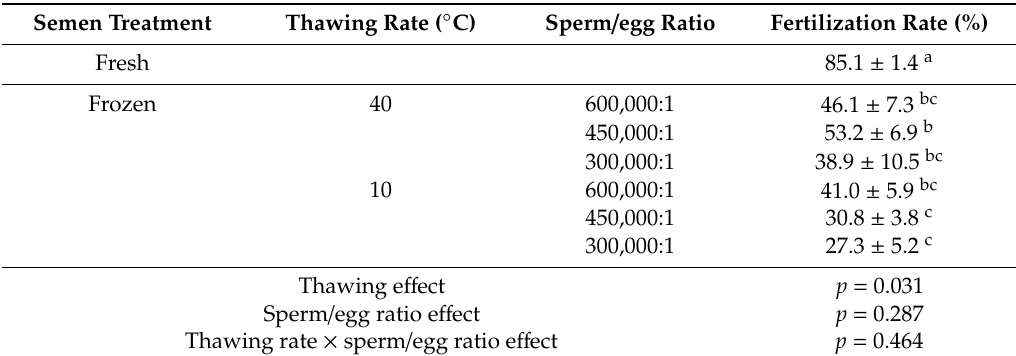
Table 2. Fertilization ability of fresh or frozen semen (mean ± SE) undergoing two thawing rates and using di ff erent sperm-to-egg ratios ( n =